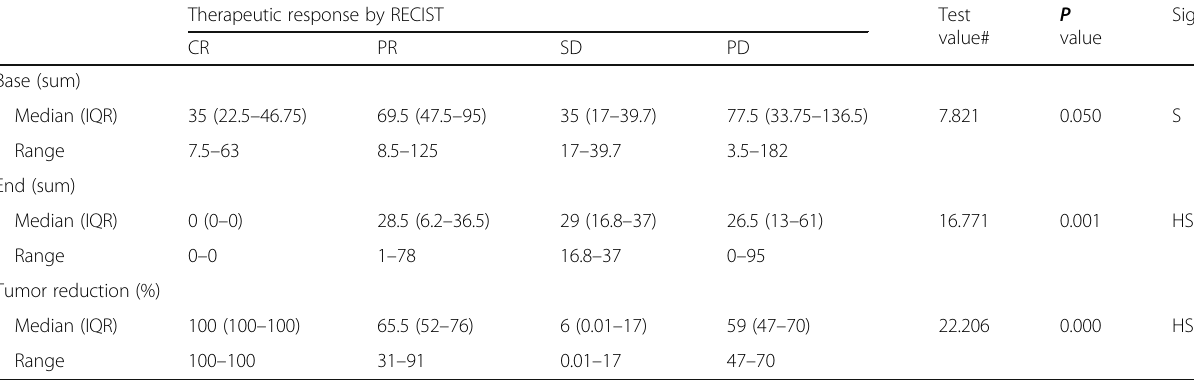
Table 4 Correlation between tumor size and CT-based therapeutic response in the study population Therapeutic response by RECIST